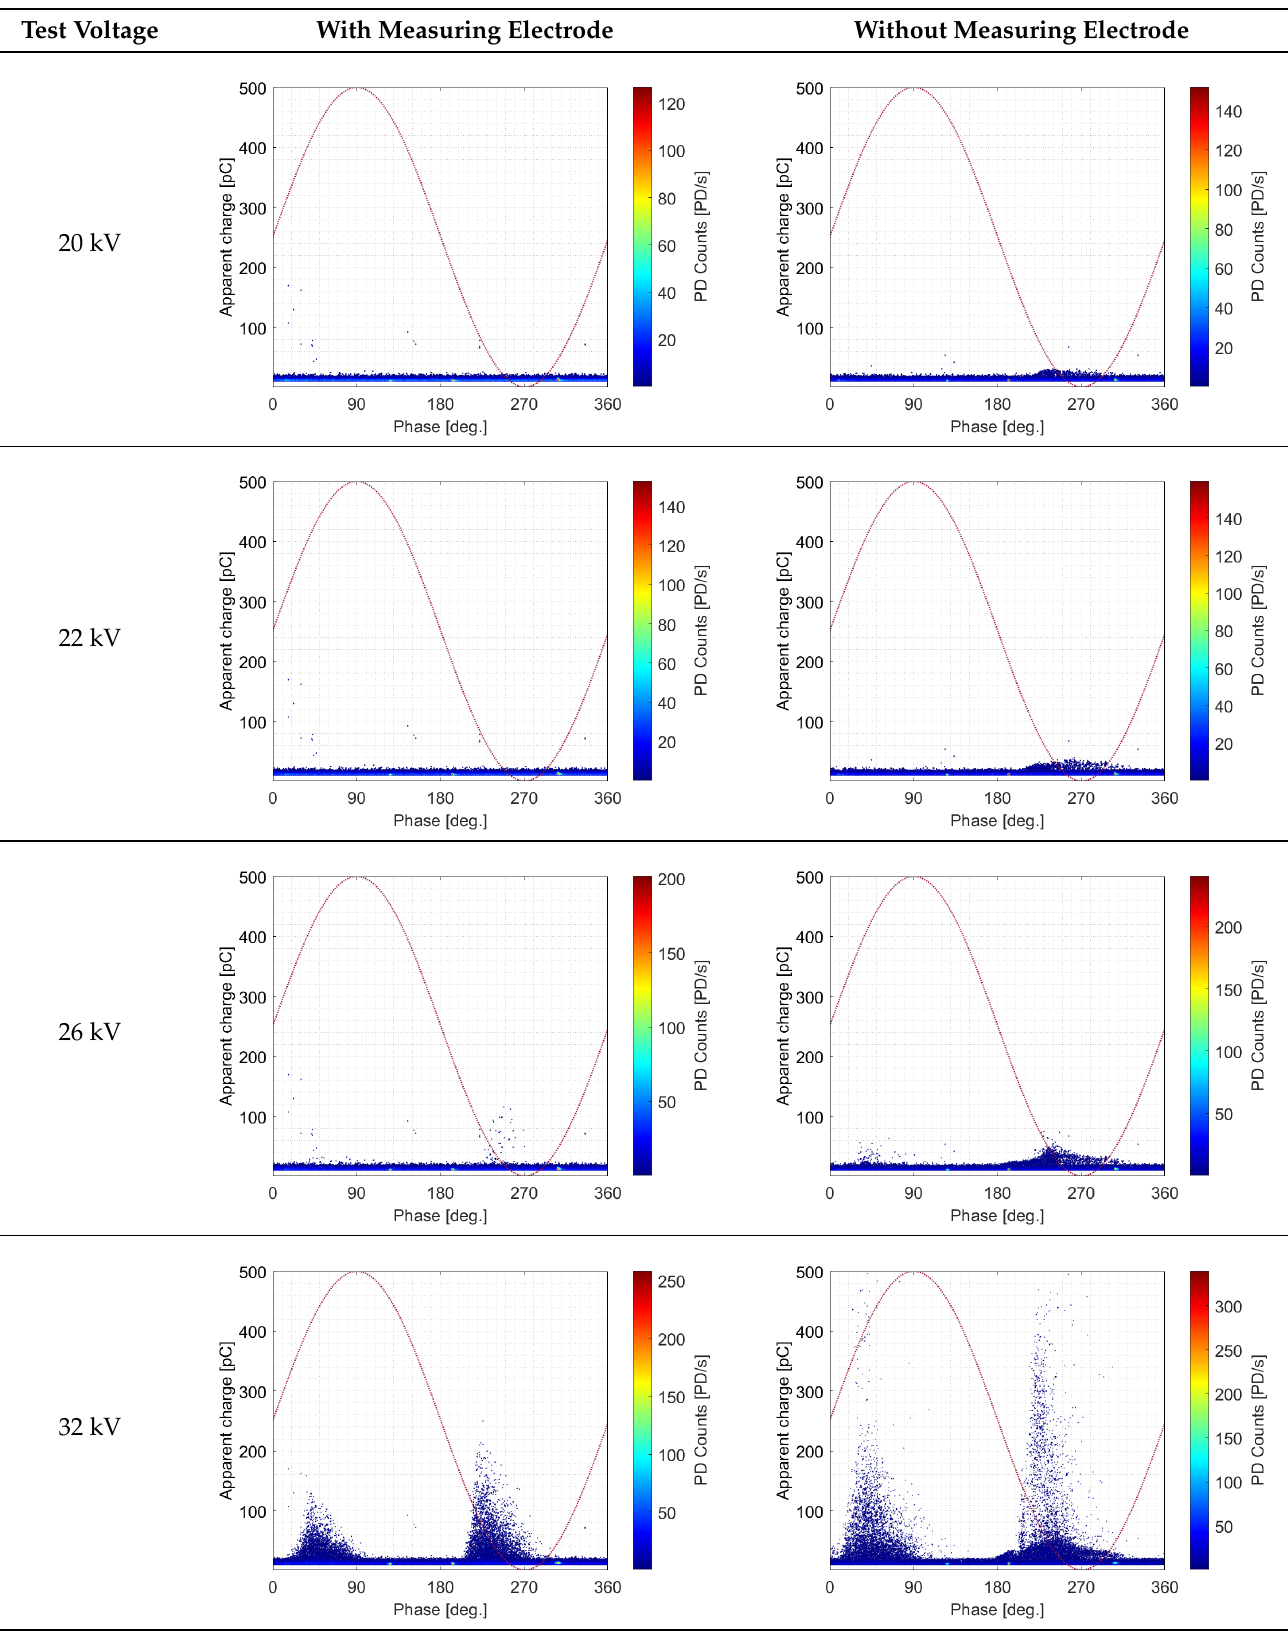
Table 5. PRPD images recorded with the HF